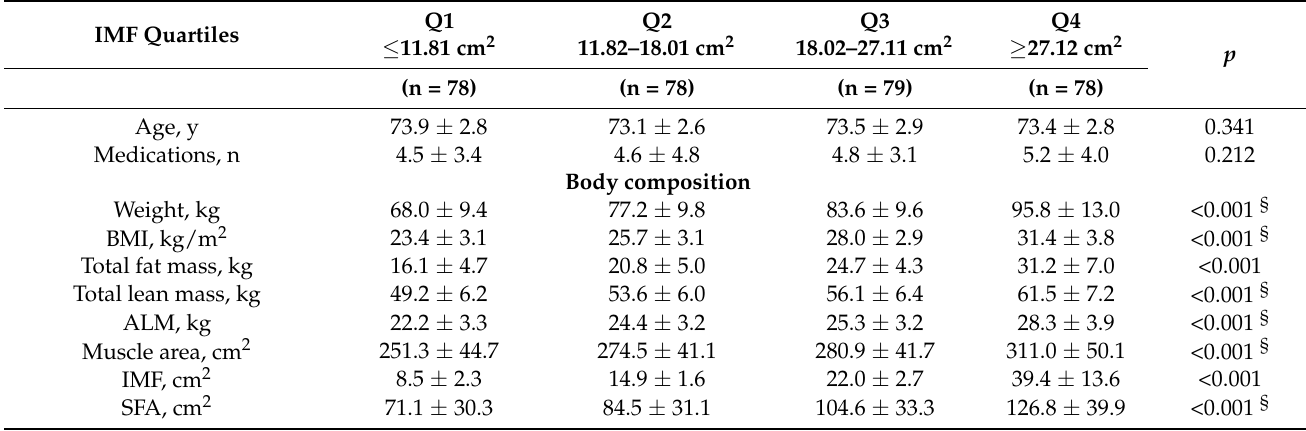
Table 1. Participant characteristics according to quartiles of intermuscular fat